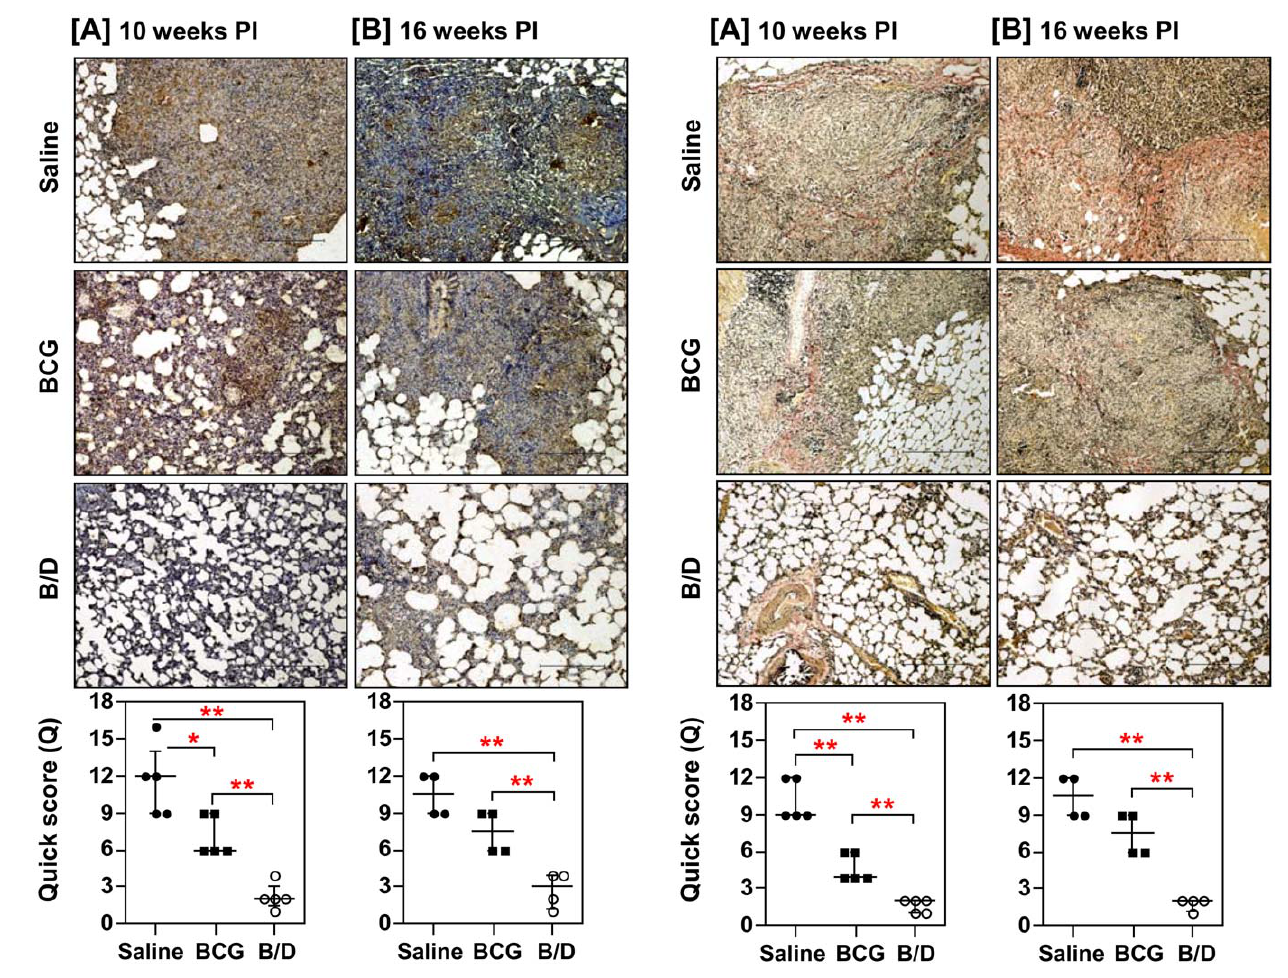
Figure 5. Influence of a -crystallin based prime boost vaccina- tion on pulmonary fibrosis following M.tuberculosis infection. The figure depicts representative photomicrographs (10 6 ) of Van Gieson stained lung sections of guinea pigs euthanized at (A) 10 weeks and (B) 16 weeks post-infection. Saline group exhibited extensive fibrosis or collagen deposition (red color) in granulomatous lesions; BCG group exhibited increased fibrosis with time and B/D group showed complete disease resolution with no evident sign of fibrosis. Scale bar represents 1 mm. Extent (Q) of pulmonary fibrosis was measured by light microscopy [Q=Intensity (I) X area (A) of staining] and represented graphically as median ( 6 inter quartile range). B/D, BCG prime – DNAacr boost. **, p , 0.01 (Mann-Whitney U